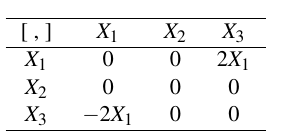
Table 1. Lie brackets for equation (1)